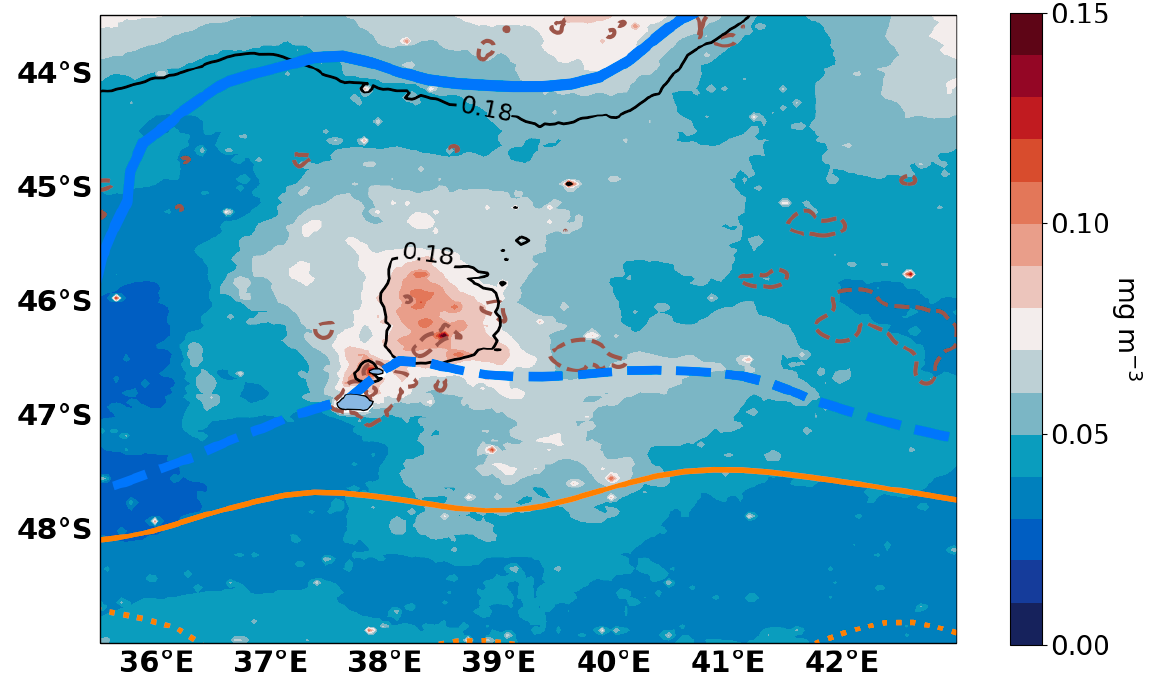
Figure 2. Standard deviation of chlorophyll a (chla; mg m − 3 ) in the Prince Edward Island (PEI) region. The black contours indicate the long-term mean 0.18 mg m − 3 chla isopleths, while the dashed brown contours indicate the 1000 m isobath. The solid and dashed thick blue lines indicate the long-term mean positions of the middle (M-SAF) and southern (S-SAF) branches of the sub-Antarctic Front, respectively, while the solid and dotted thick orange lines show the long-term mean positions of the northern (N-APF) and middle (M-APF) branches of the Antarctic Polar Front, respectively.